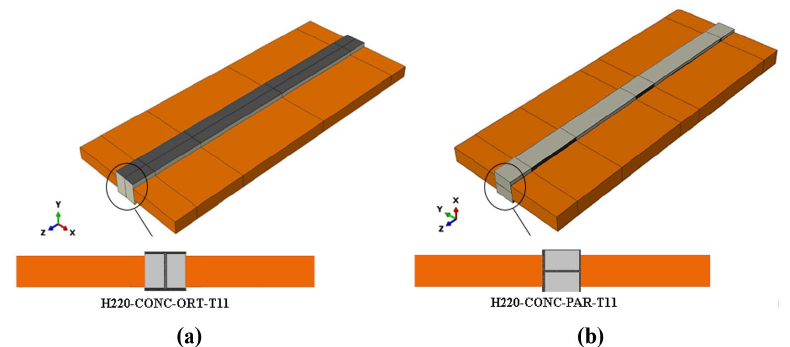
Figure 2. Representation of the thermal models for the columns: a) H220-CONC-ORT-T11; b)